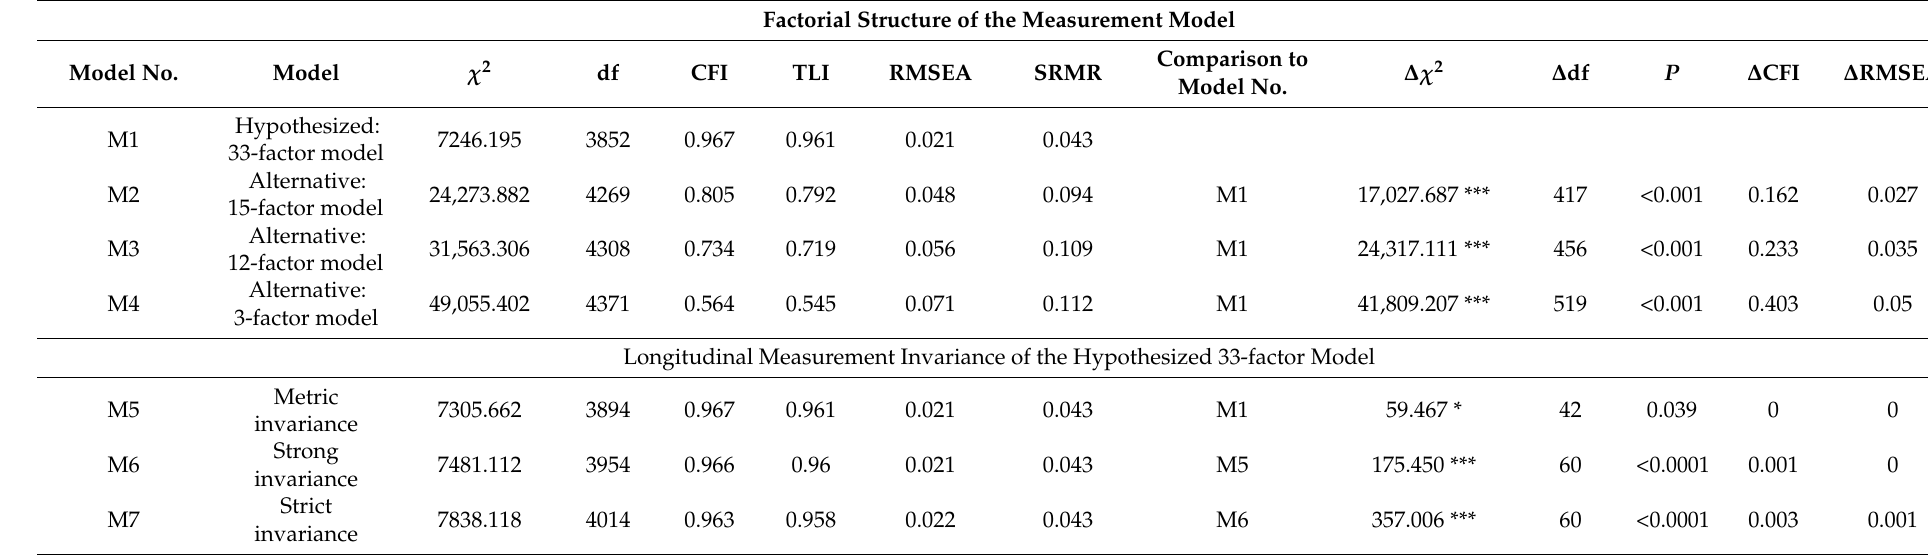
Table 2. Fit indices of competing nested factor models and standardized maximum likelihood estimates. Factorial Structure of the Measurement